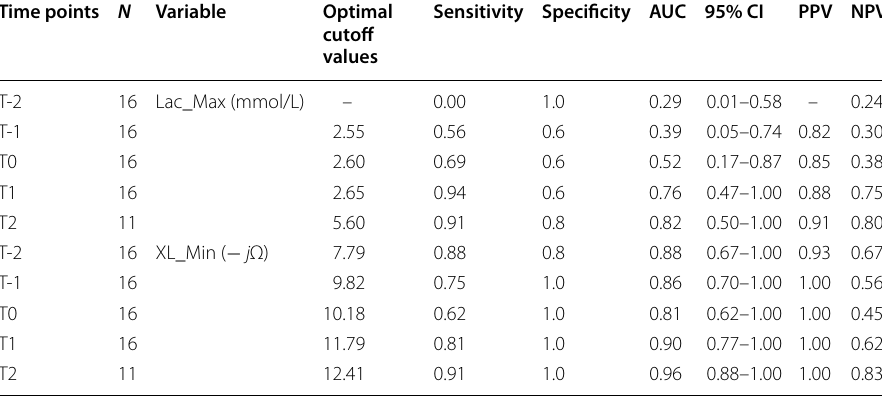
Performance for maximum lactate values per subject per event (Lac_Max) and minimum XL values per subject per event (XL_Min) between the control group (CG) and the shock group (SG). All subjects were considered in the relevant time points by the shock criterion (MAP 48 mmHg) T‑2: 2 h before shock; T‑1: 1 h before shock; T0: shock; T1: 1 h after shock; T2: 2 h ≤ after shock AUC area under the curve, CI confidence interval, NPV negative predictive value, PPV positive predictive